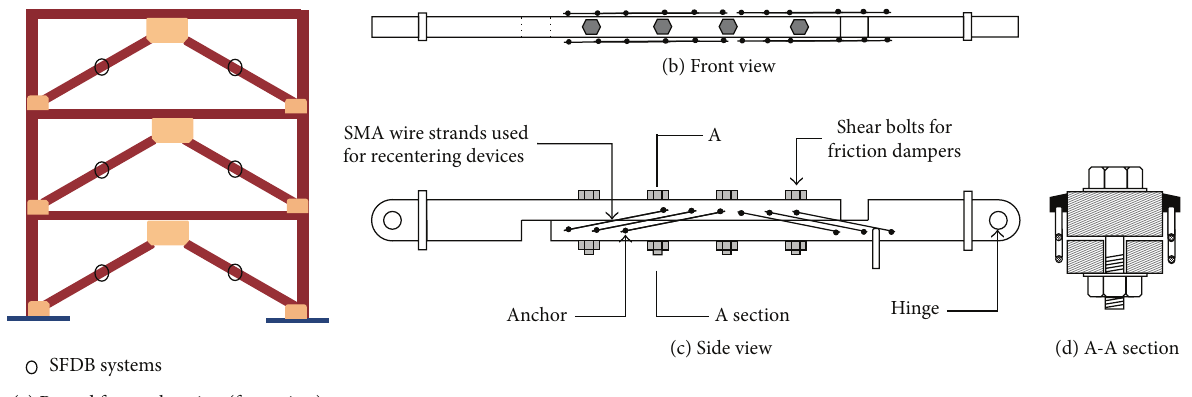
Figure 2: Design and application of the self-centering friction damping brace (SFDB) system.